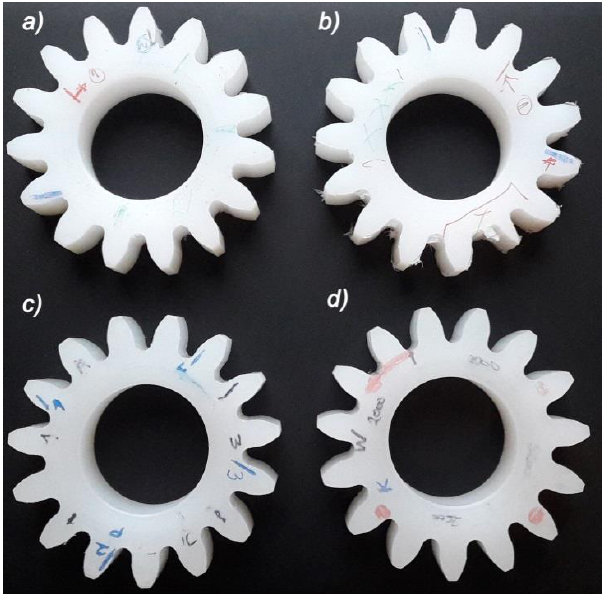
Figure 12. Gear wheels after machining, ( a ) PE1000, ( b ) PE1000 after heat treatment, ( c ) PVDA, ( d ) PVDA after heat treatment.